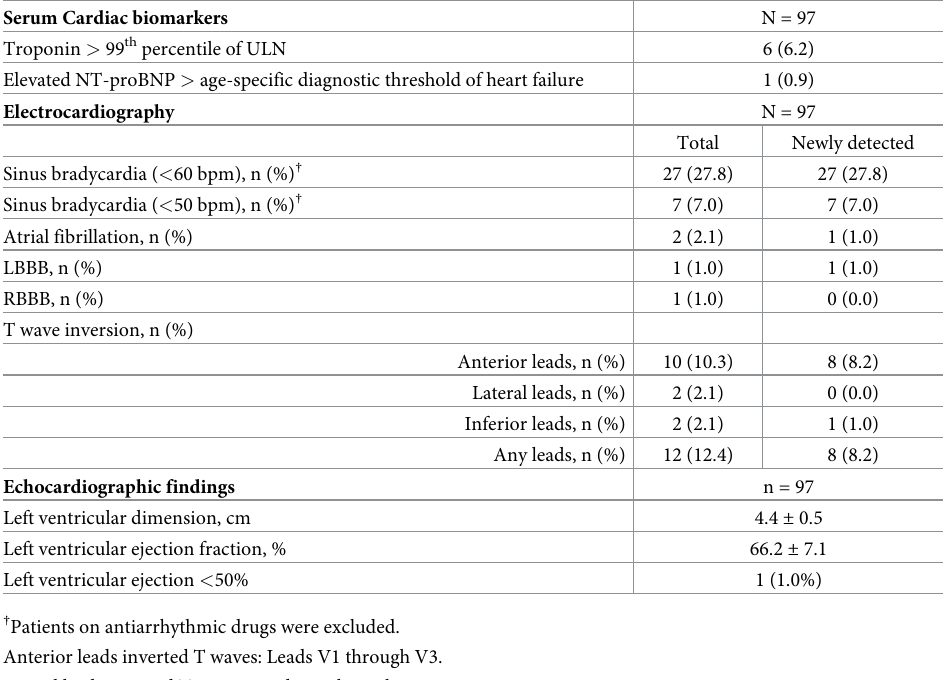
Table 2. Cardiac abnormalities detected during screening. Serum Cardiac biomarkers N = 97 Troponin > 99 th percentile of ULN 6 (6.2) Elevated NT-proBNP > age-specific diagnostic threshold of heart failure 1 (0.9) Electrocardiography N = 97 Total Newly detected Sinus bradycardia ( < 60 bpm), n (%) † 27 (27.8) 27 (27.8) Sinus bradycardia ( < 50 bpm), n (%) † 7 (7.0) 7 (7.0) Atrial fibrillation, n (%) 2 (2.1) 1 (1.0) LBBB, n (%) 1 (1.0) 1 (1.0) RBBB, n (%) 1 (1.0) 0 (0.0) T wave inversion, n (%) Anterior leads, n (%) 10 (10.3) 8 (8.2) Lateral leads, n (%) 2 (2.1) 0 (0.0) Inferior leads, n (%) 2 (2.1) 1 (1.0) Any leads, n (%) 12 (12.4) 8 (8.2) Echocardiographic findings n = 97 Left ventricular dimension, cm 4.4 ± 0.5 Left ventricular ejection fraction, % 66.2 ± 7.1 Left ventricular ejection < 50% 1 (1.0%) † Patients on antiarrhythmic drugs were excluded. Anterior leads inverted T waves: Leads V1 through